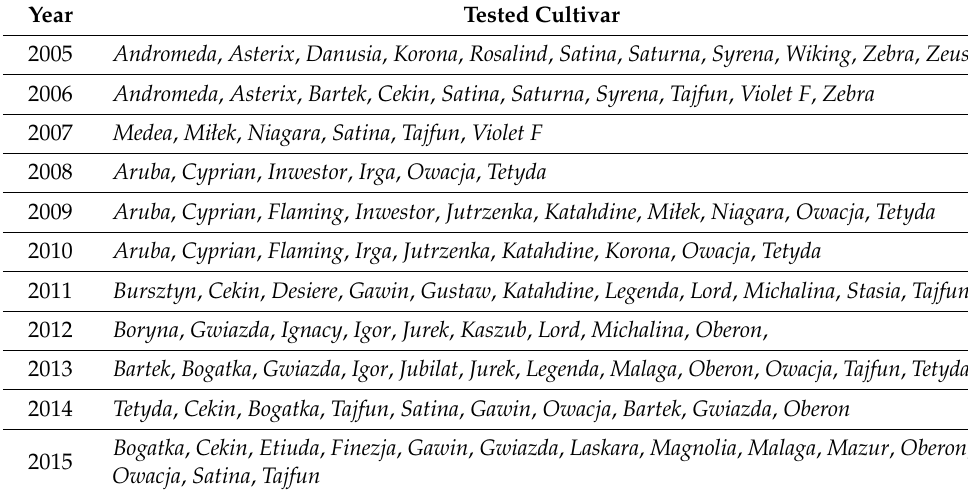
Table 1. Cultivars tested in a particular year.